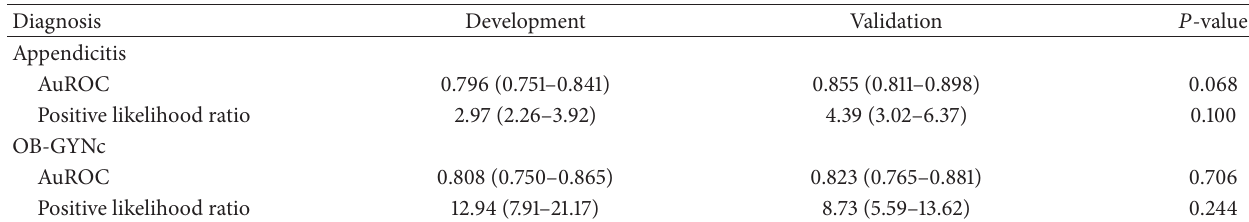
Table 6: Areas under receiver operating characteristic curves (AuROC) and positive likelihood ratios (and 95% confidence intervals) of the scoring system for appendicitis and OB-GYNc in the development and validation